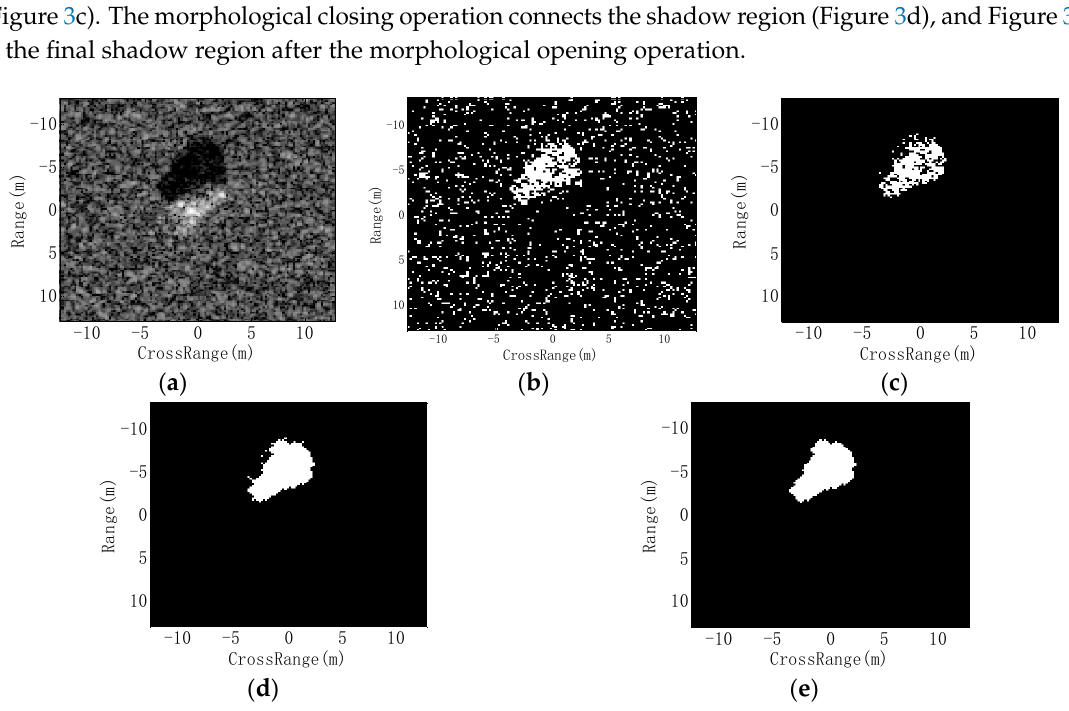
Figure 3. Illustration of the shadow extraction: ( a ) original image; ( b ) after the threshold segmentation; ( c ) after the counter filter; ( d ) after the morphological closing operation; and ( e ) after the morphological opening operation.